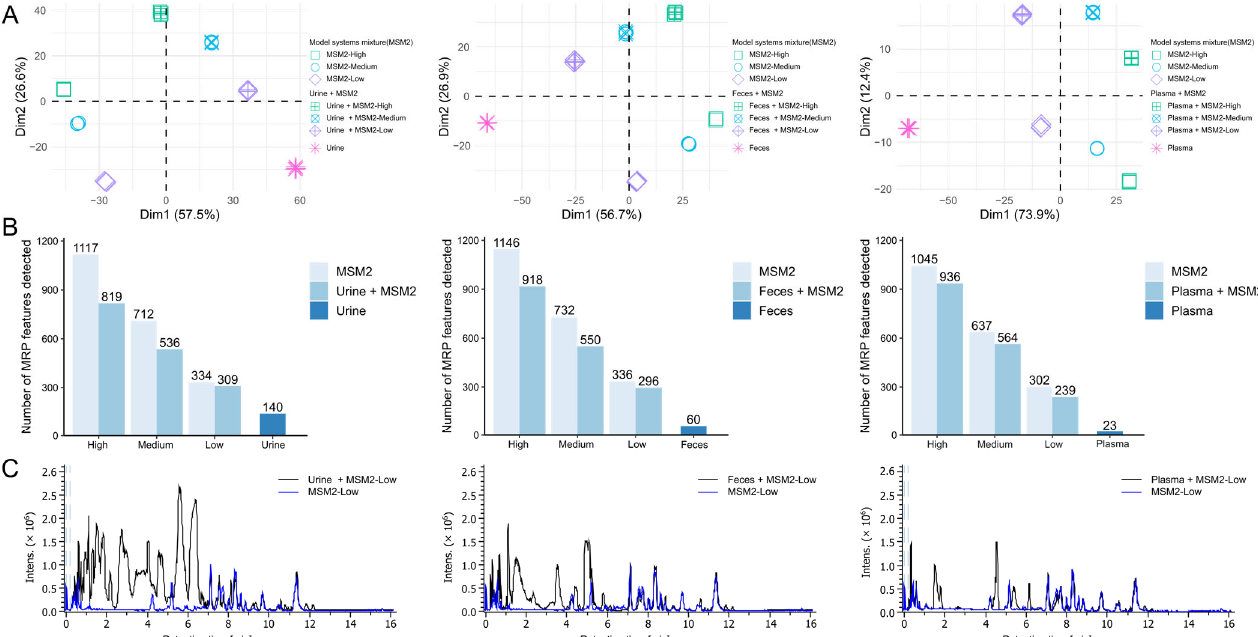
Figure 6. Detectability of glycation products in the biological matrices. ( A ) Principal component analysis (PCA) score plots of biological samples, a model system mixture (lysine and arginine; MSM2), and model system-spiked biological samples, in an order of urine, feces, and plasma. Prior to spiking, the model system mixture was either not diluted ( high ) or diluted 1:5 ( medium ) or 1:25 ( low ). Measurement was performed using the optimized HILIC method described in Section 2. ( B ) Bar plots representing the number of detected MRP features depending on the dilution level and biological extracts. ( C ) Representative base peak chromatograms of MSM2-Low and MSM2-spiked biological